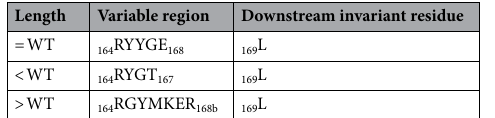
Table 3. Examples of the proposed numbering scheme for length-variant